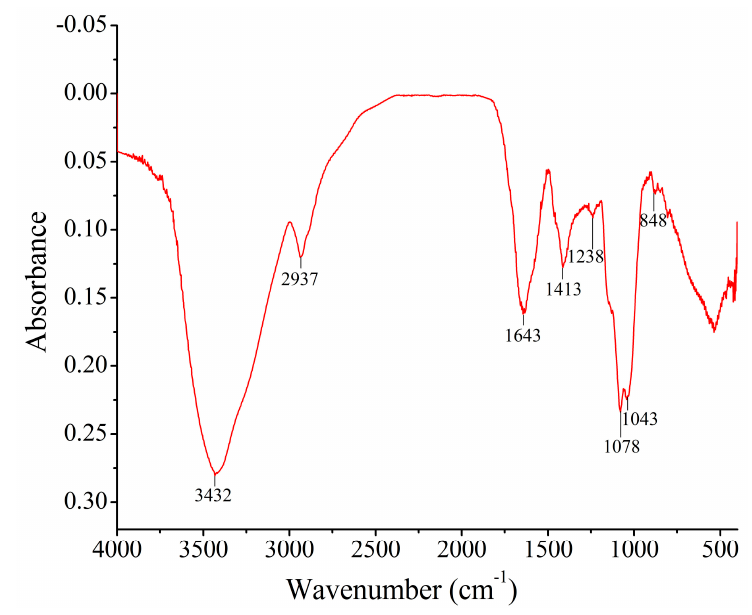
Figure 6. Fourier transform infrared (FT-IR) spectrum of En-OPS.